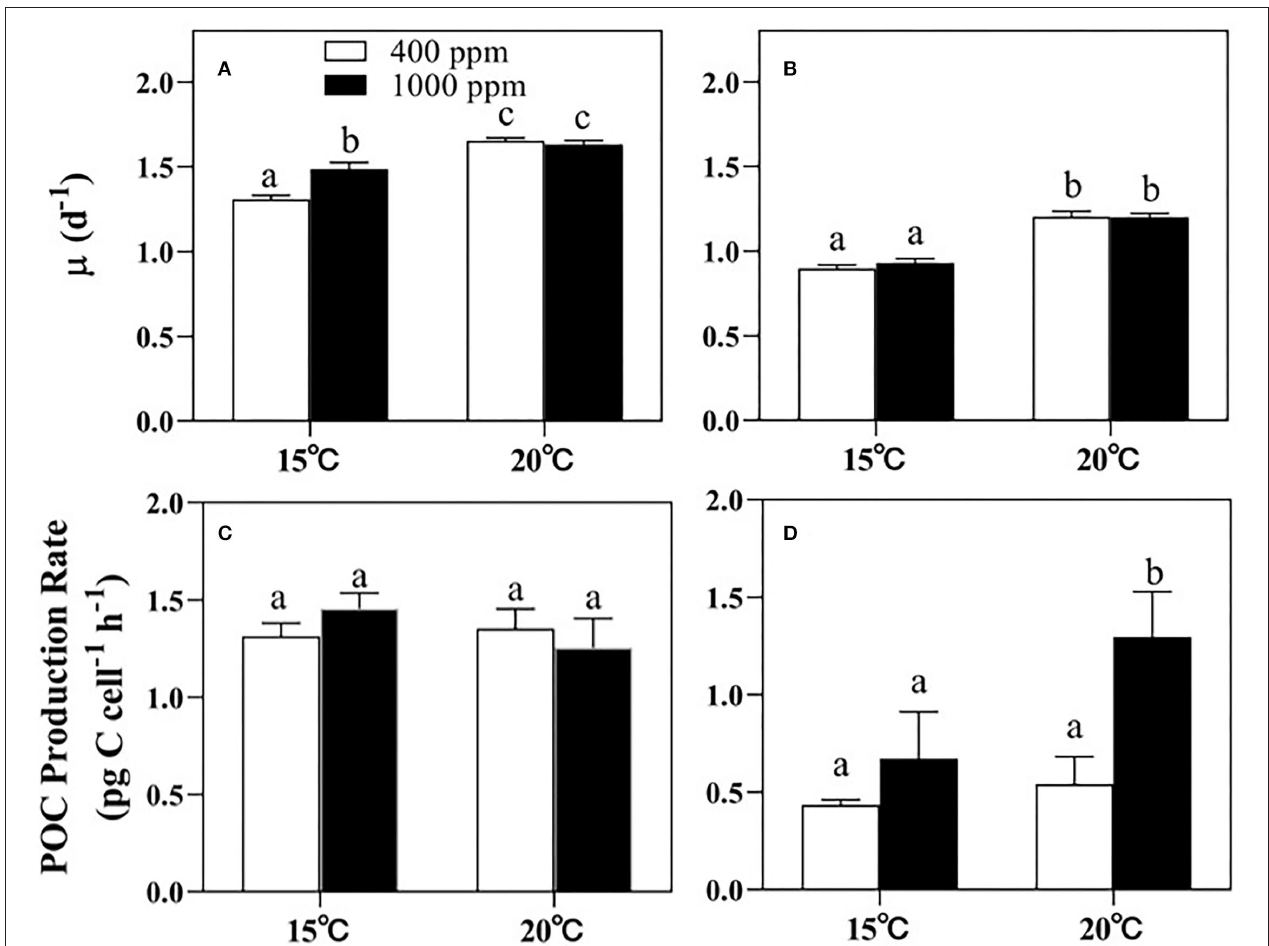
FIGURE 1 | The growth rates and the POC production rates of Thalassiosira sp. (A,C) and N. closterium f.minutissima (B,D) under different pCO 2 and temperature conditions. The error bars represent standard deviations of triplicate samples. The letters above the bars denote the statistically significant differences. POC, particulate organic